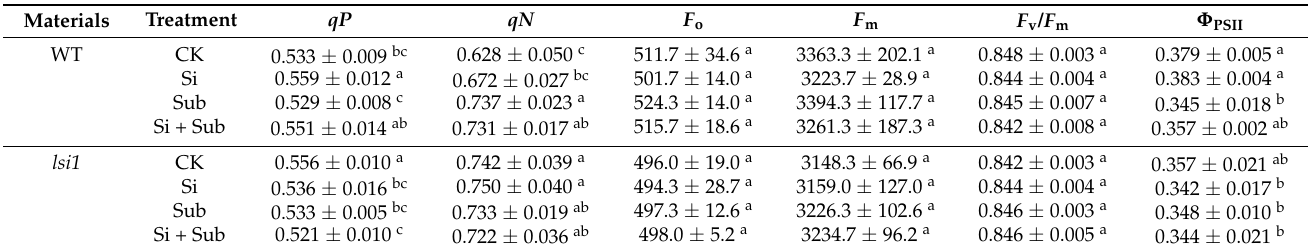
Table 3. Effects of Si application on chlorophyll fluorescence of rice under submergence